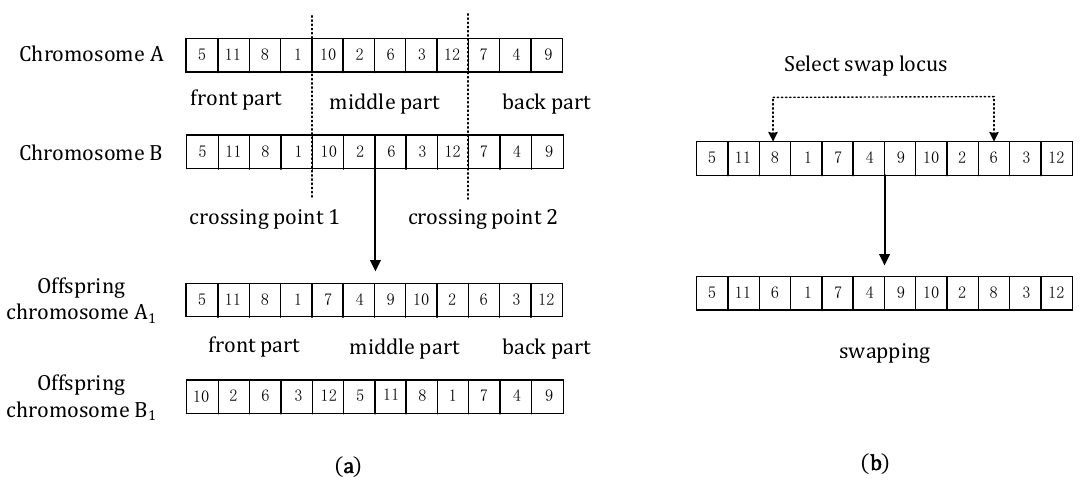
Figure 5. Crossover mutation diagram. ( a ) An example of a crossover process; ( b ) an example of a mutation process.